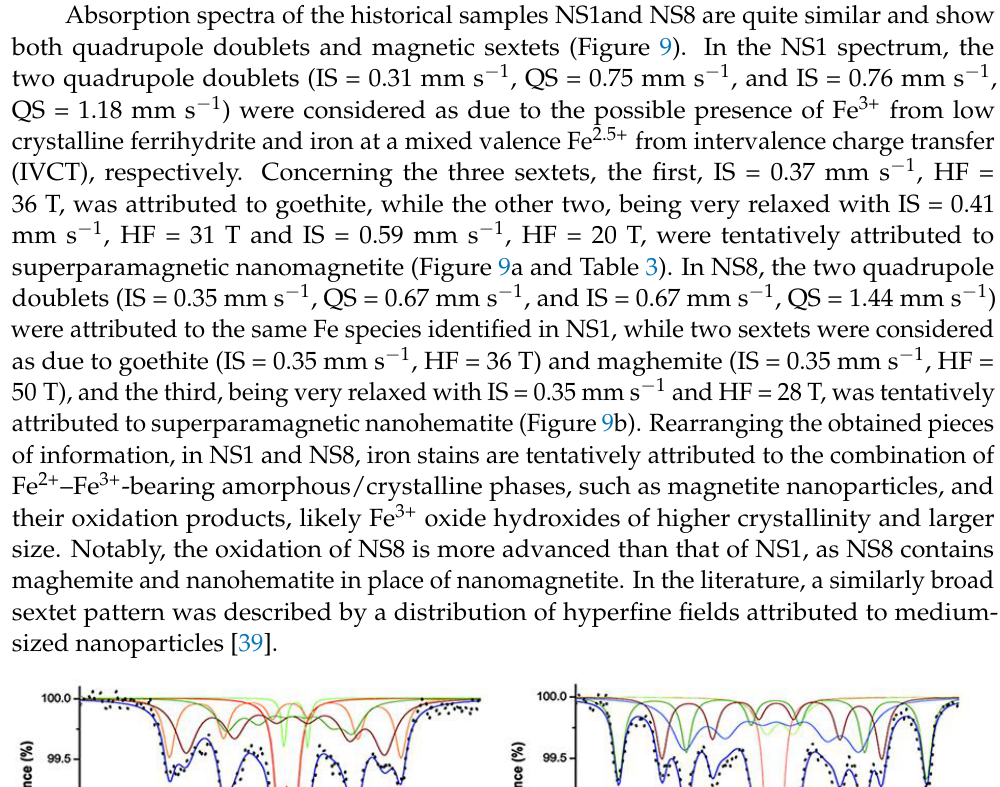
Figure 8. Mössbauer spectra of: ( a ) marble samples stained outdoors after exposure of one-to-four seasons (see Figure 7 for details); ( b ) sample AS25 stained for three months in a highly humid envi- ronment. Observed absorption intensity (I obs, black dots) and calculated total intensity (I calc, con- tinuous blue line) are plotted together with calculated absorption components (continuous red line for the Fe 3+ central doublet, green and cyan for Fe 3+ sextets).